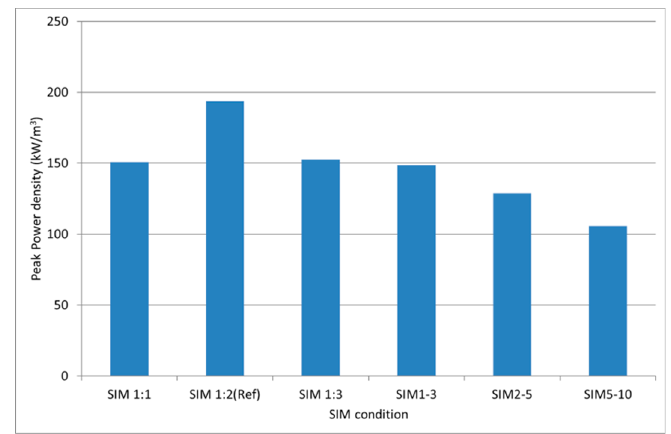
Figure 10. The impact of SIM condition on the maximum peak power density achievable using linear volumetric scaling of the reactor.